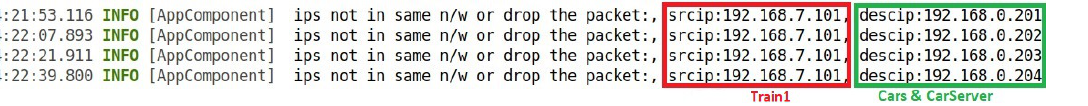
Figure 23. Screenshot of SDN application log: ping from Train1 to Car1,Car2, Car3, and